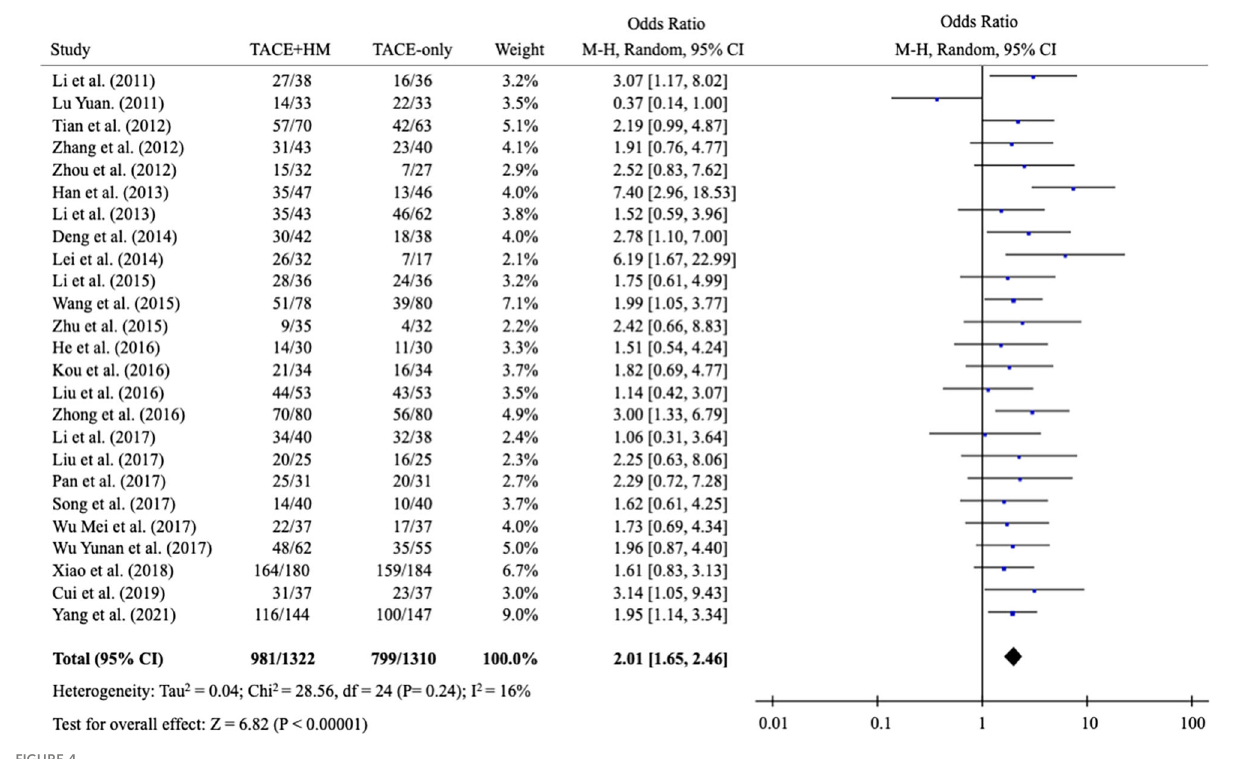
FIGURE 4 Meta-analysis of overall survival at